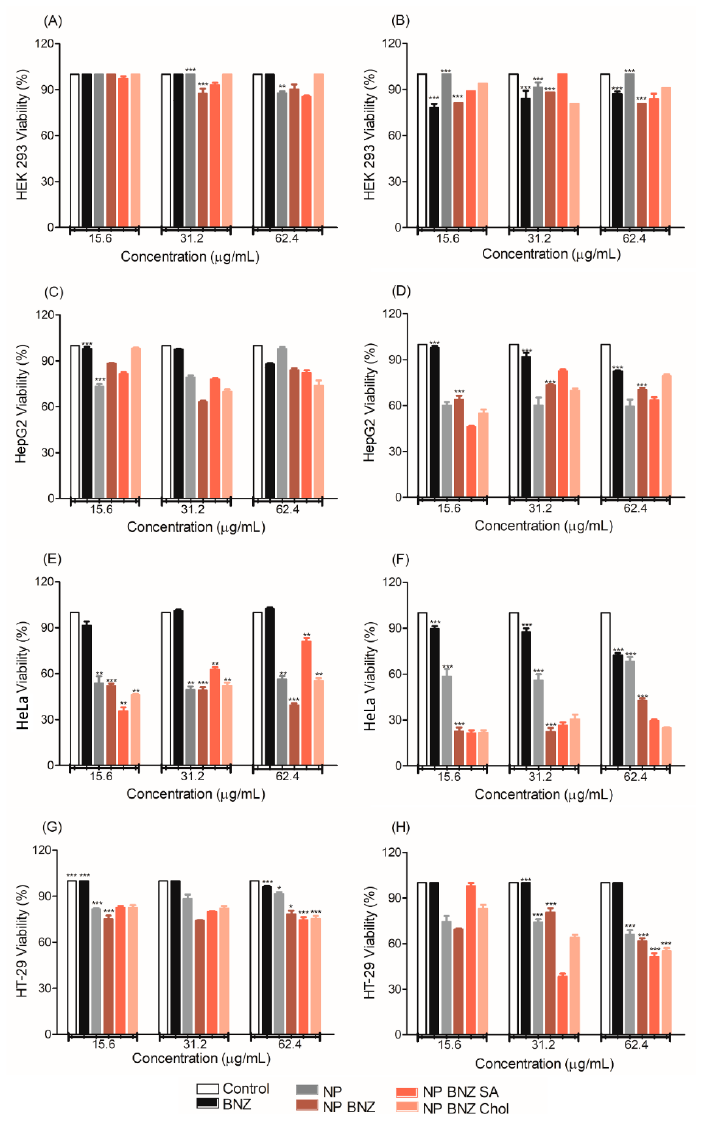
Figure 5. Cytotoxicityofthecontrol(DMEMsupplementedwith10%( v / v )fetalbovineserum), benznidazol (BNZ), drug-free NPs (NP), drug-loaded NPs (NP BNZ), SA-functionalized drug-loaded NPs (NP BNZ SA), and Chol-functionalized drug-loaded NP (NP BNZ Chol), as a function of test concentration, as determined by the MTT assay in four different cell lines after 24 h and 48 h of incubation. ( A , B ) Normal kidney HEK 293 cell line, ( C , D ) Human hepatocyte carcinoma (HepG2) cell line, ( E , F ) Human carcinoma cervical cancer (HeLa) cell line, and ( G , H ) human colorectal cancer (HT-29) cell line. Notes: The data are expressed as the mean ± standard deviation (SD) ( n = 3), (*): p < 0.05, (**): p < 0.01, and (***): p <